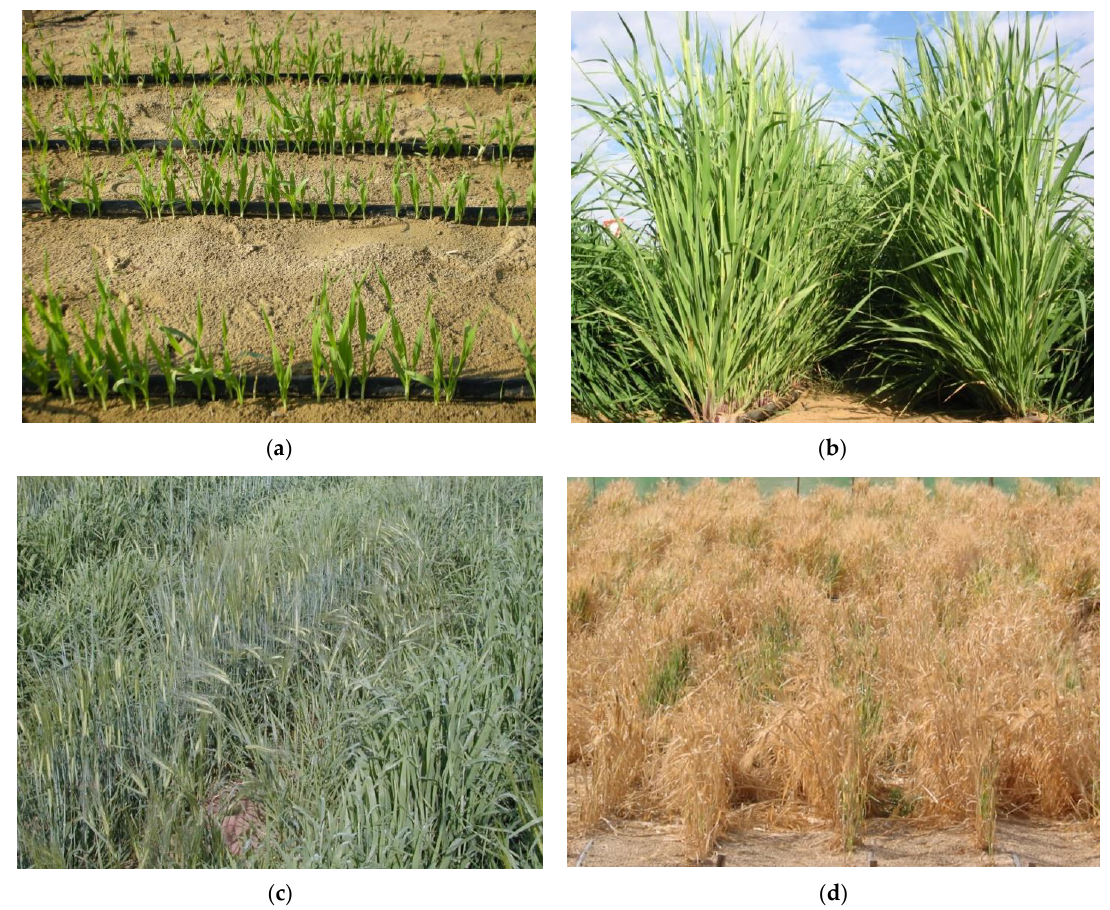
Figure 2. ( a ) Barley field plots for sustainable crop production in sandy marginal hyper-arid desert soils at ICBA, Dubai, UAE. ( b ) Irrigation systems, seedling growth, tillering and spike develop- ment. ( c ) Barley crop at grain filling stage. ( d ) Barley crop at maturity stage. Table 2. Physical and chemical characteristics of experimental soil. Soil Characteristics Sample Location